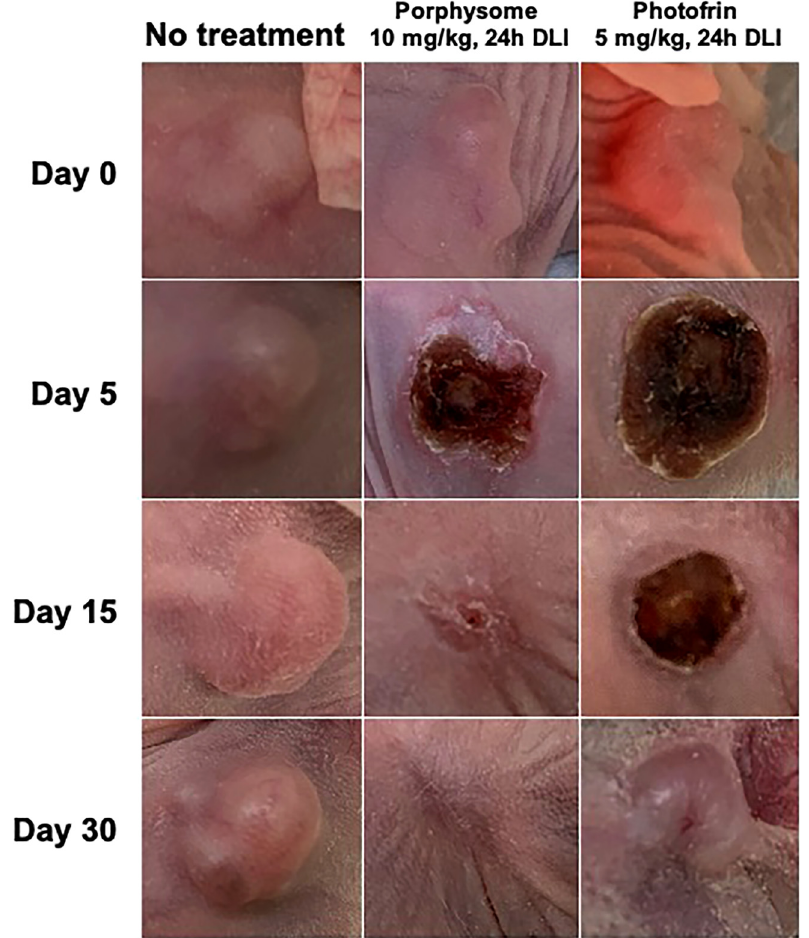
Figure 8: Representative photographs of animal tumors at four time-points ( t = 0, t = 5 days, t = 15 days, and t = 30 days) in untreated control (left), porphysome-PDT (10 mg/kg, 24 h DLI, middle), and Photofrin- PDT (5 mg/kg, 24 h DLI, right) groups.